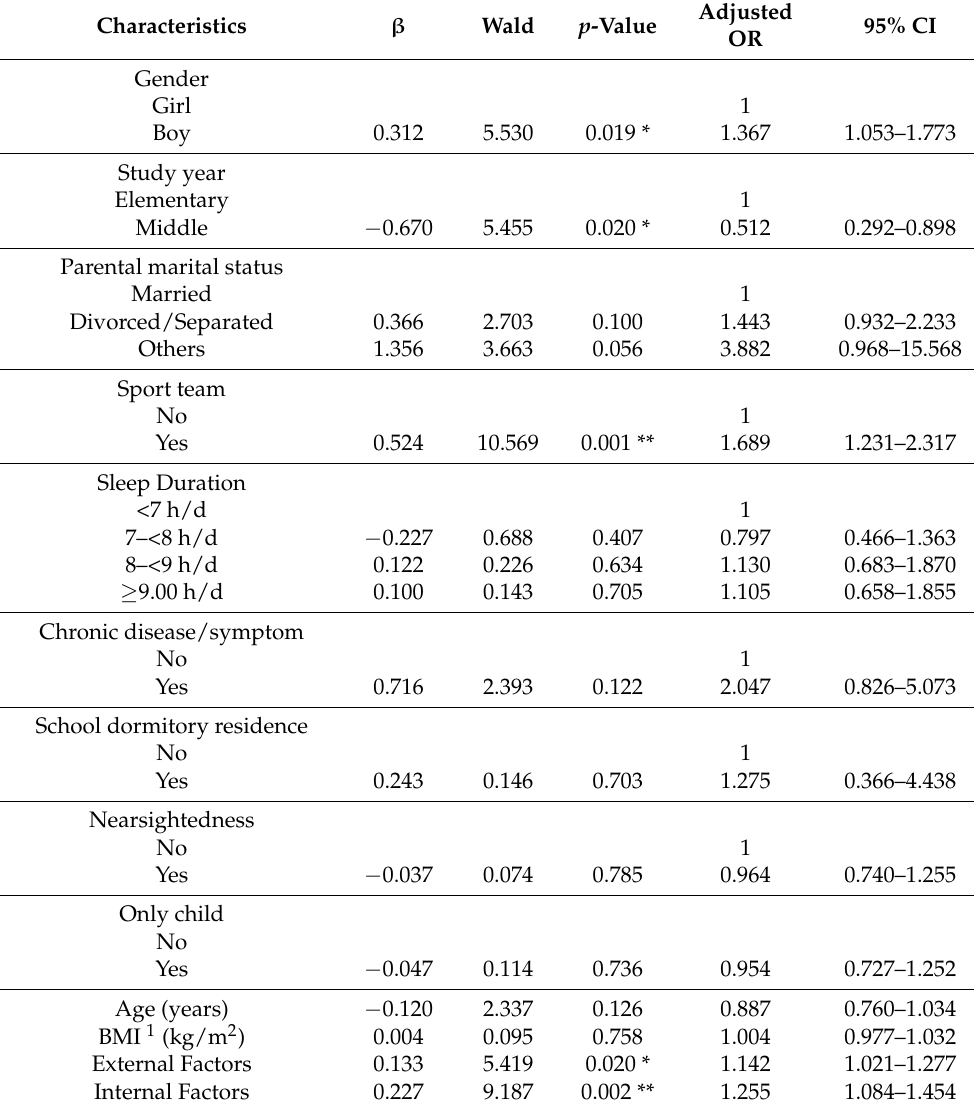
Table 5. Multivariate logistic regression to estimate risks for school sports injury among elementary and middle school students in Shanghai, China ( N =